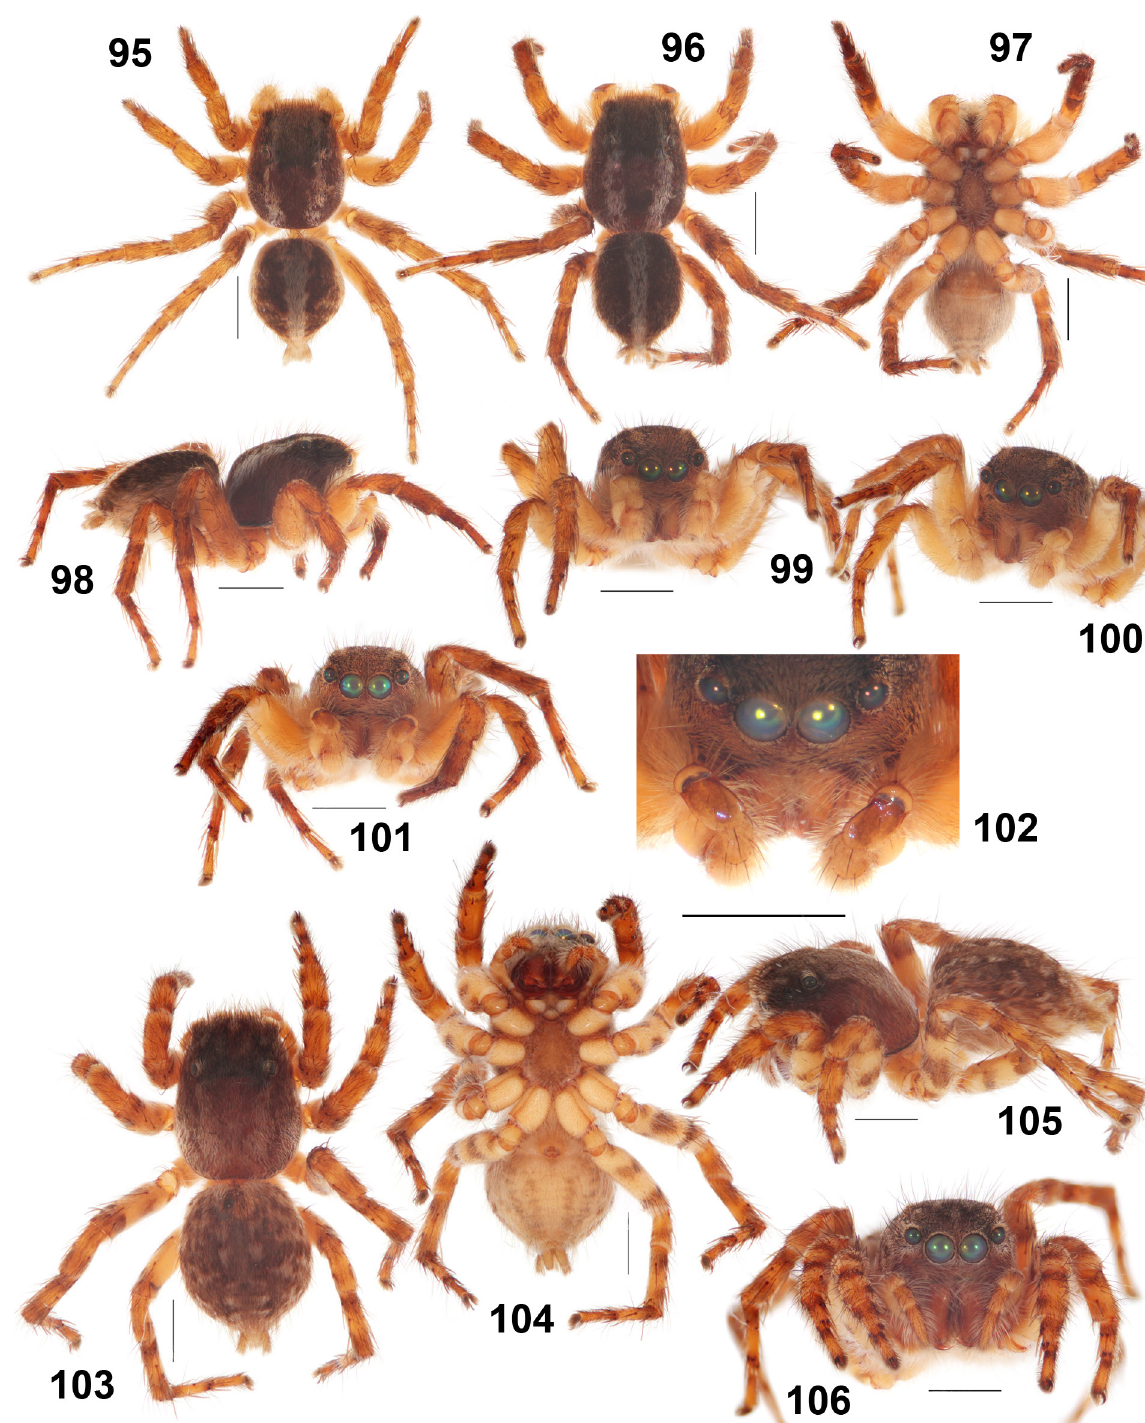
Figs 95–106. Manzuma kenyaensis (Dawidowicz & Wesołowska, 2016) gen. et comb. nov., ♂ from Kwaisagat (MMUE G 7572.12) (95–102), ♀ from Naro Moru (ISEA 001.8307) (103–106), general appearance. Scale bars: 1